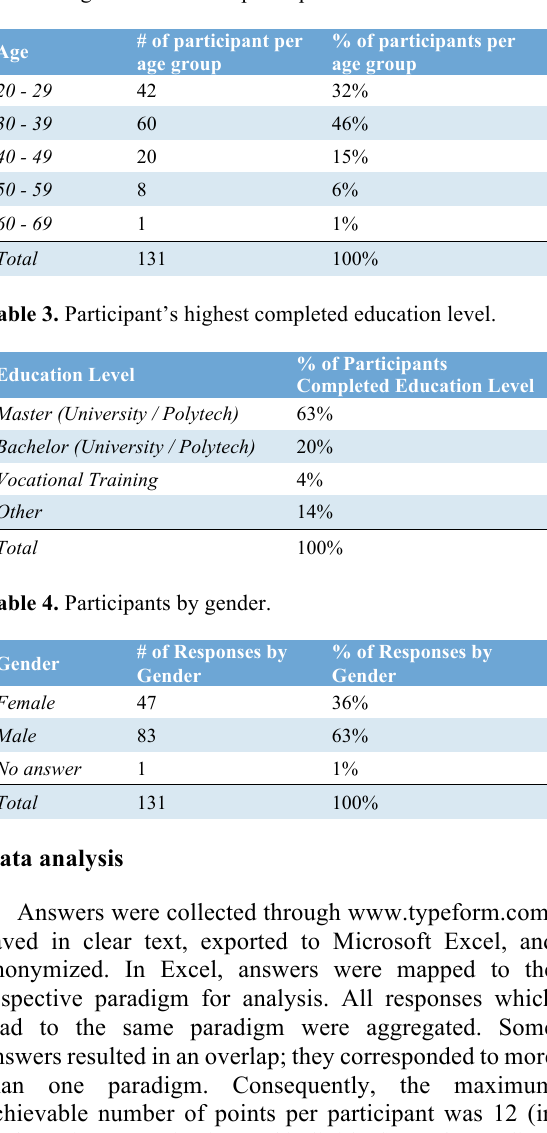
Table 2. Age distribution of participants.